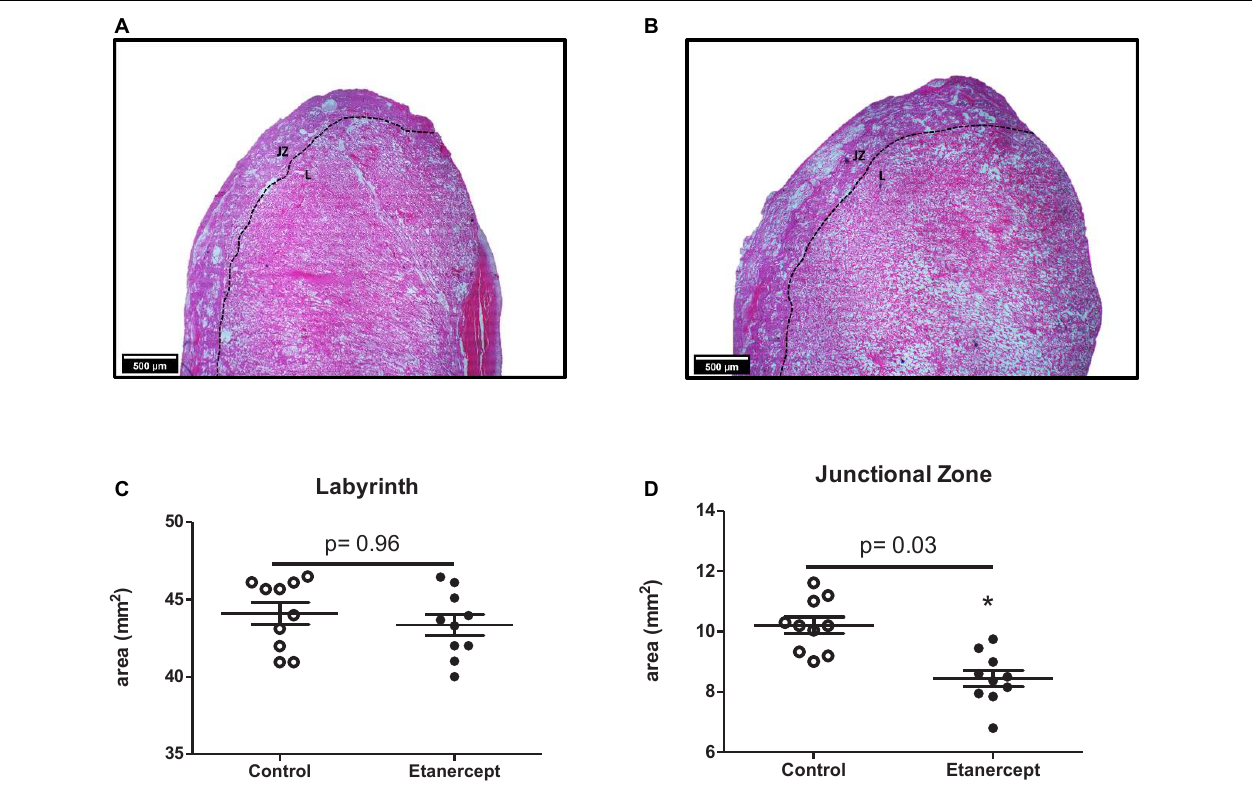
FIGURE 2 | Placental area [junctional zone (ZJ) and labyrinth (L)] of control and etanercept-treated rats. Photomicrography specifying the placental regions of the control group (A) and etanercept-treated group (B) . Placental (C) labyrinth and junctional zone (D) areas (mm 2 ) from the control group (open circles, n = 10) and etanercept-treated group (dark circles, n = 10). * p < 0.05 vs. control group (Student’s t -test).